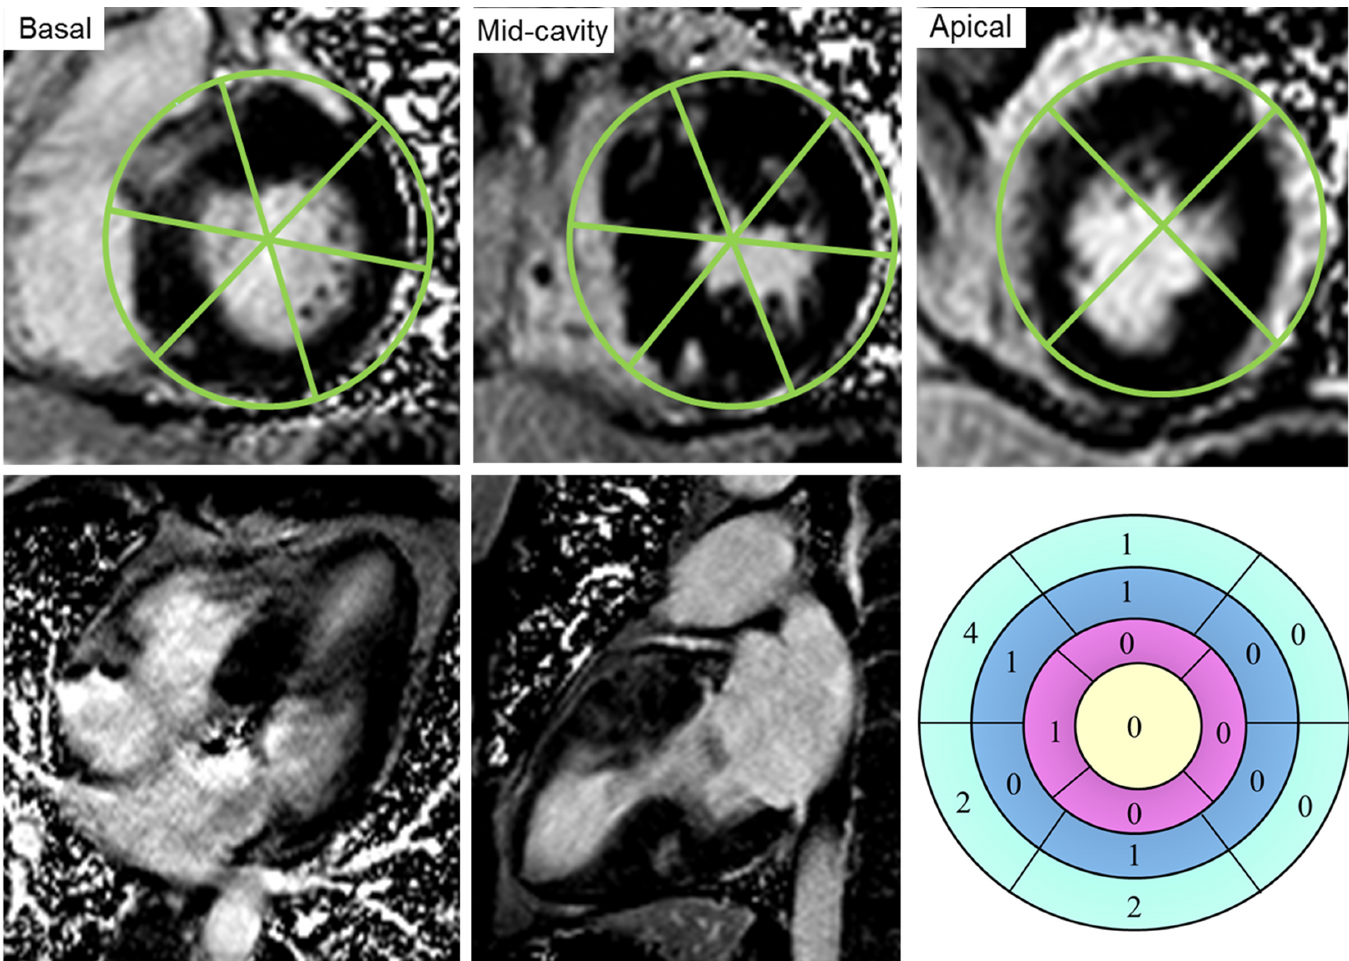
Fig 1. A schematic diagram of the quantification of LGE by the visual scoring method based on the standard 17-segment model of the left ventricle. The number in each segment represents the corresponding LGE score of that segment. By adding each individual segment score, the total LGE score was 13 for this patient. The extent of LGE (LGE %) was then calculated as 19.1% ([13/68]×100). Details of the scoring procedure are described in the Methods section. LGE indicates late gadolinium